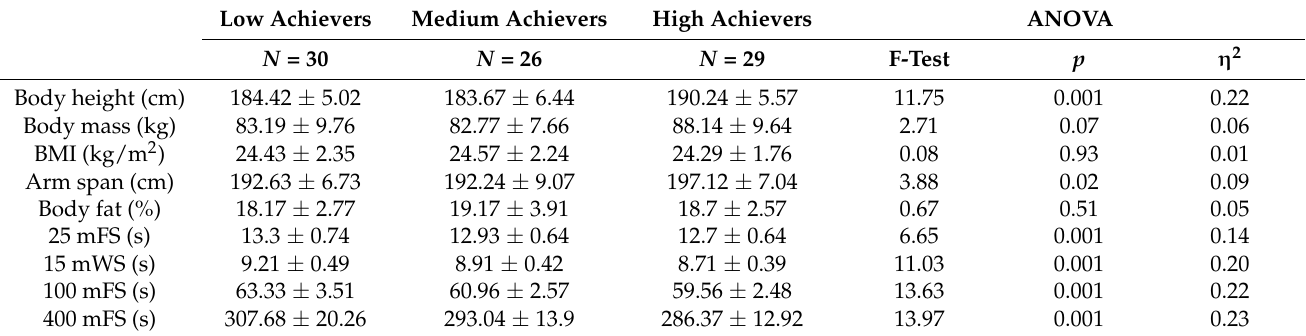
Table 1. Descriptive statistics and differences derived by analysis of variance (ANOVA) among qualitative groups for total sample of water polo players (results are presented as means ± standard